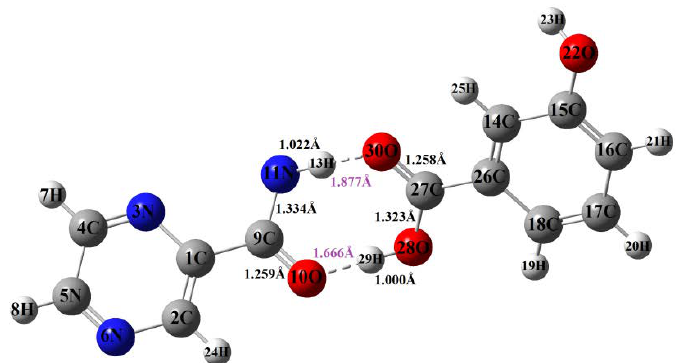
Figure 7. Typical bond lengths of the cocrystal between PZA and 3-hBA (bond length shown with unit